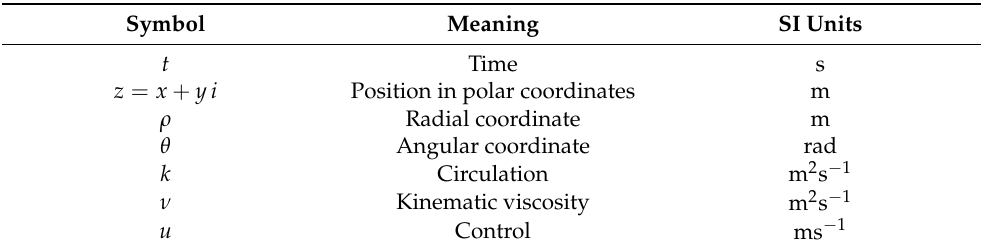
Table 1. Nomenclature